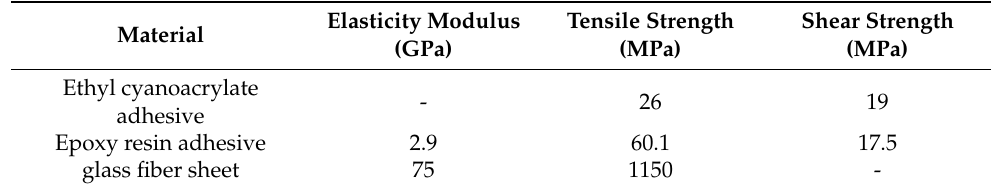
Table 1. Mechanical properties of the materials.